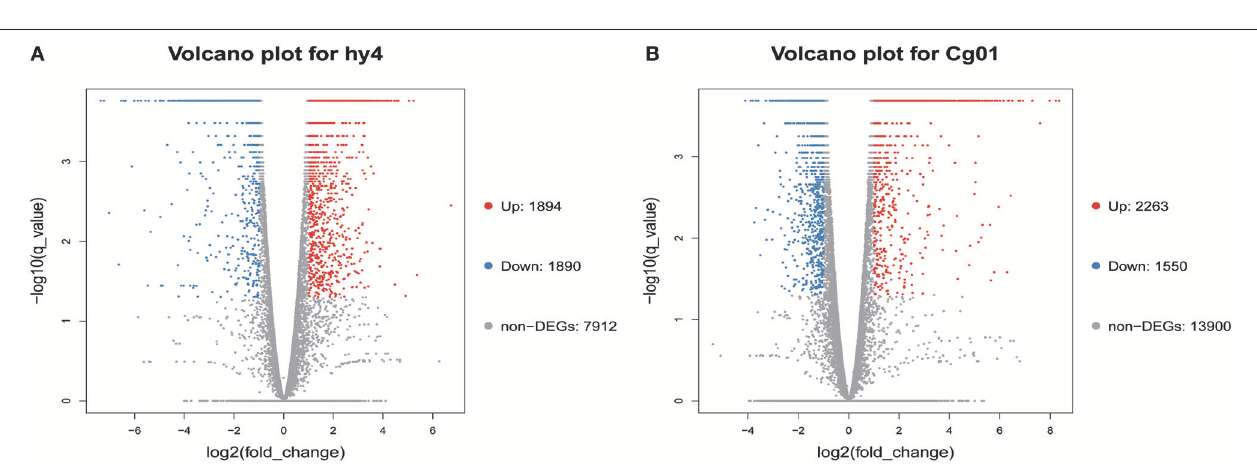
FIGURE 5 | Volcano plots of differentially expressed genes in two endophytic fungi (A) P. polonicum hy4; (B) C. gloeosporioides Cg01. Volcano plots visualize the DEGs between the two different groups. Q -values ≤ 0.05 and | log2(fold_change) | ≥ 1 were used as a threshold to determine the significance of DEGs. Red dots: up-regulated genes; Blue dots: down-regulated genes; Gray dots: genes with no significant difference.